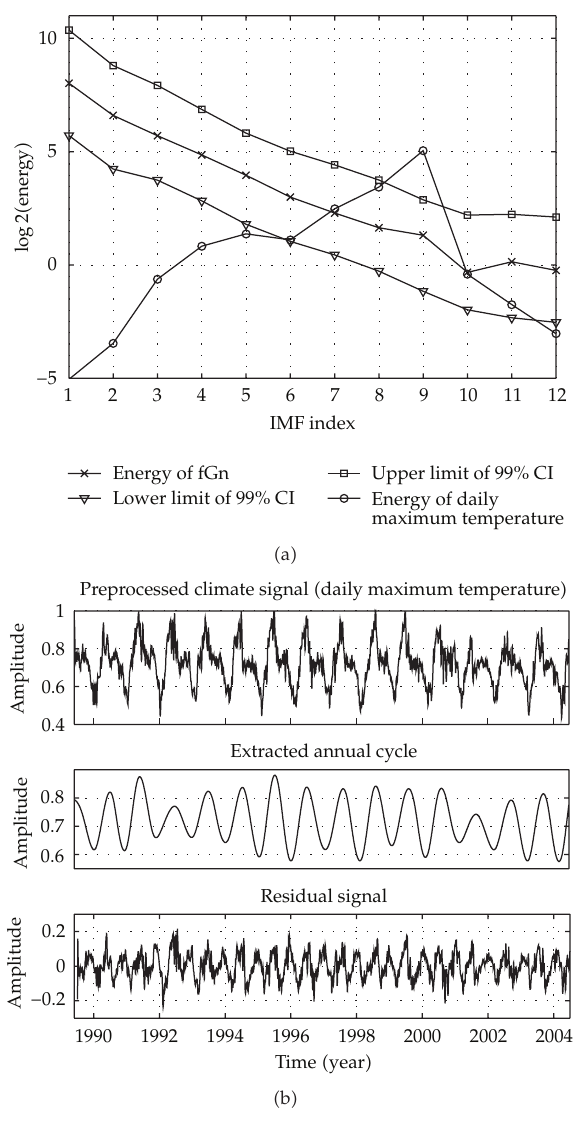
Figure 9: (cid:2) a (cid:3) The energy distribution of fGn over the IMFs, its upper and lower bounds with 99% confidence interval. The energies of individual IMF of daily max. temperature signal indicate that the 9th one is the starting IMF to represent the annual cycle. (cid:2) b (cid:3) The separation of annual cycle of daily maximum temperature. The preprocessed climate signal (cid:2) top (cid:3) , extracted annual cycle (cid:2) middle (cid:3) , and the residual signal (cid:2) bottom (cid:3)